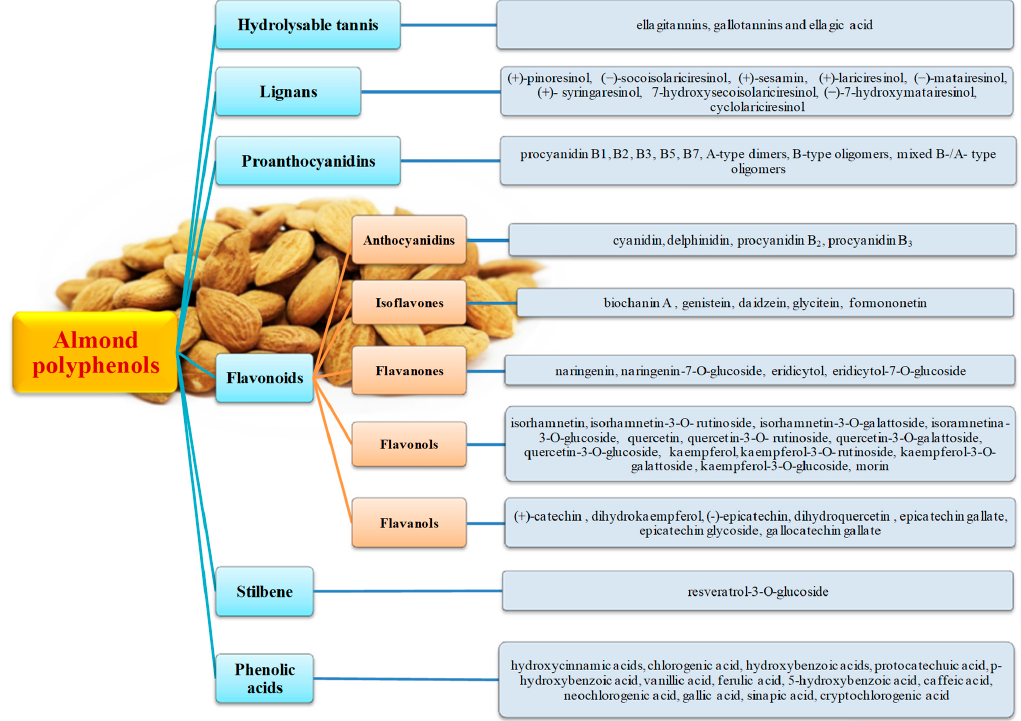
Figure 1. Main polyphenols present in whole almonds.